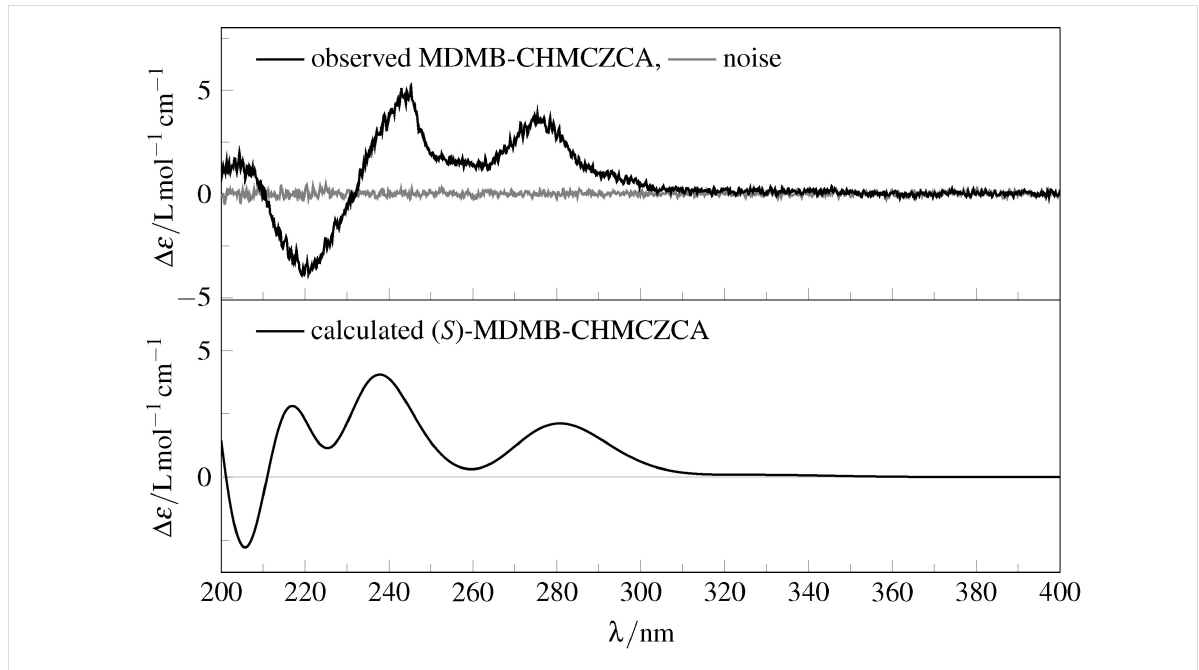
(ESI) [16] of only 34% in favor of the S -enantiomer, therefore not enabling a reliable assignment of the absolute